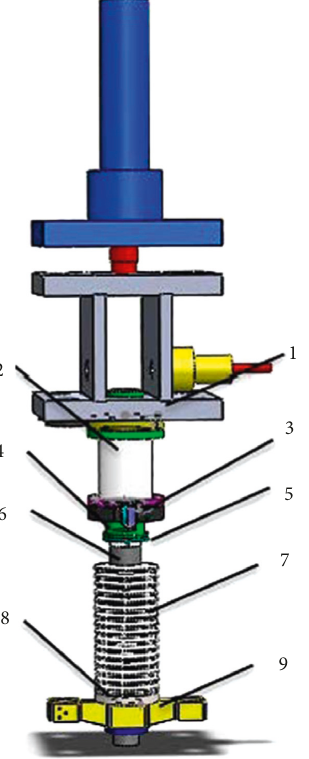
Figure 2: Energy control components: 1, movable beam; 2, hy- draulic cylinder; 3, displacement wire sensor; 4, piston rod; 5, spring mat flange; 6, impact rod; 7, disc spring group; 8, flange; 9, hammer head.